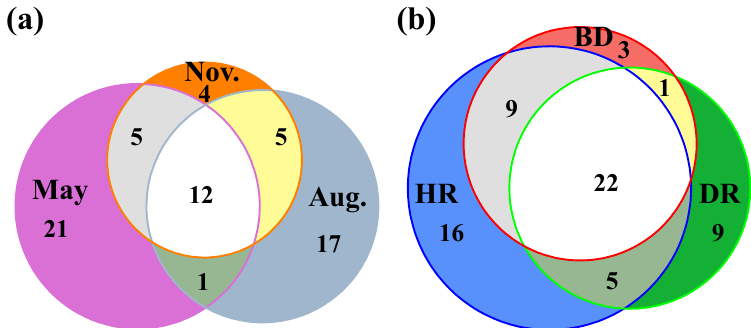
Figure 3. Changes in zooplankton taxa compositions among different sampling months and areas in DJKR. Number of shared taxa (overlapping parts of the circles) and unique taxa (parts of the circles with no overlaps) among the sampling months and areas are shown with Venn diagrams ( a ) and ( b ), respectively.